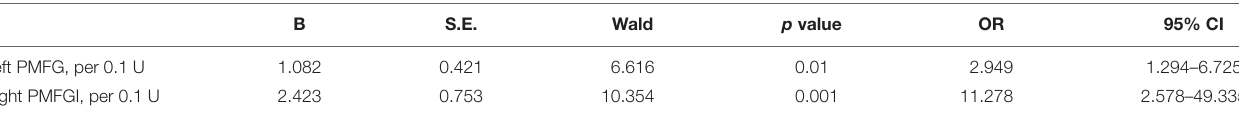
significant functional connectivity with the left PMFG was